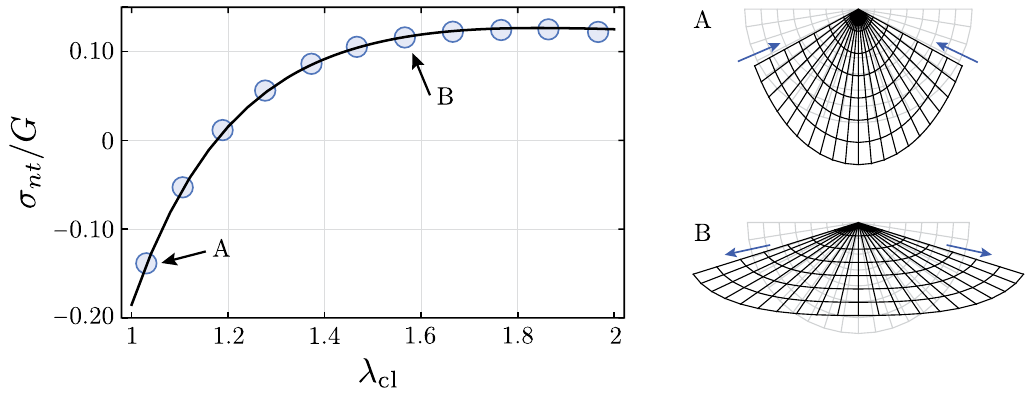
. The Marangoni stress can be cl